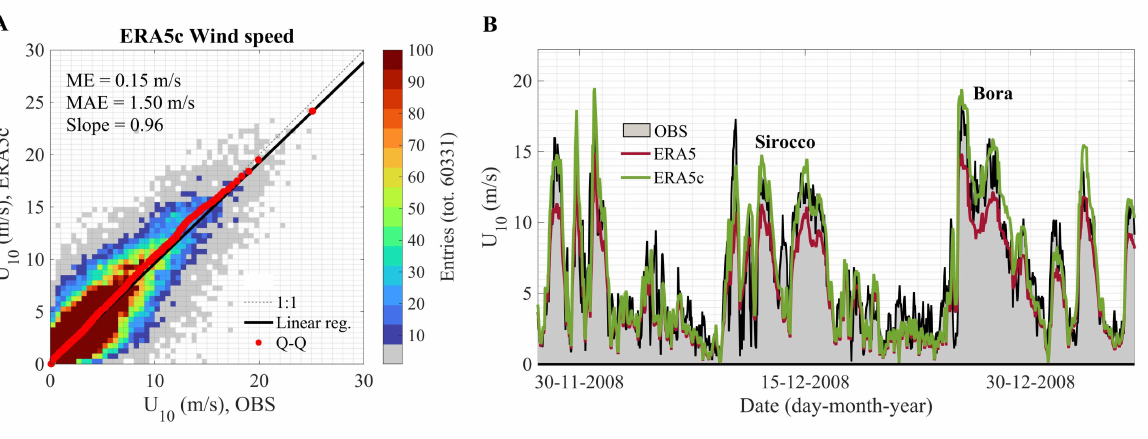
Figure 10. Performance of ERA5c wind speed ( U 10 , in m/s). Comparison with in situ observations (OBS) in the northern Adriatic Sea (Acqua Alta oceanographic platform, AA) during years 2004–2010. ( A ) Scatter diagram (color shade, linear scale) and quantile-quantile plot (Q-Q, red markers) at 1%-interval up to 99th and 0.1% interval above. Mean error ( ME ), mean absolute error ( MAE ), and slope ( Slope ) of the line of best fit (thick black) are shown in the plot area. The dashed black line indicates the perfect 1:1 match between datasets. ( B ) Example of time series comparison between measured (gray area), ERA5 (red line), and ERA5c (green line) speeds. Two Sirocco and Bora storms are indicated in the plot area.